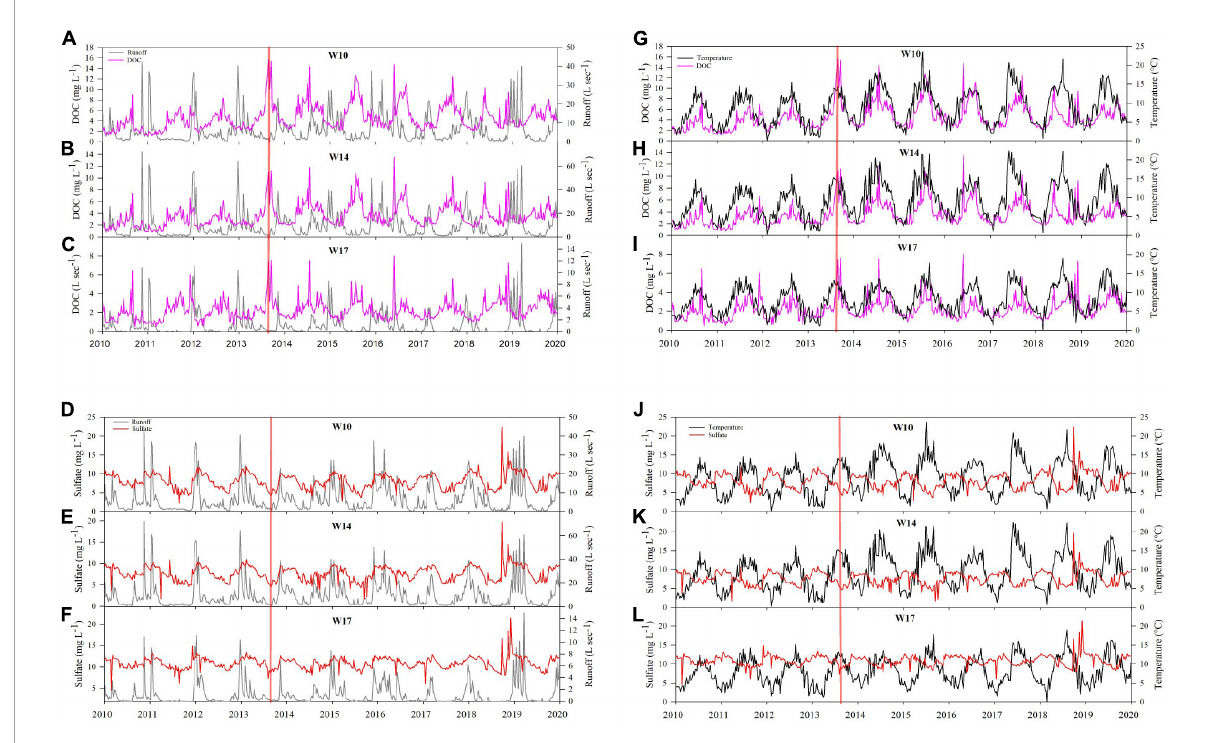
FIGURE2 Time series of dissolved organic carbon (DOC)/sulfate with runoff and temperature, respectively at the three Wüstebach catchment stations (W10, W14, W17). The vertical red line indicates the moment deforestation occurred in late summer